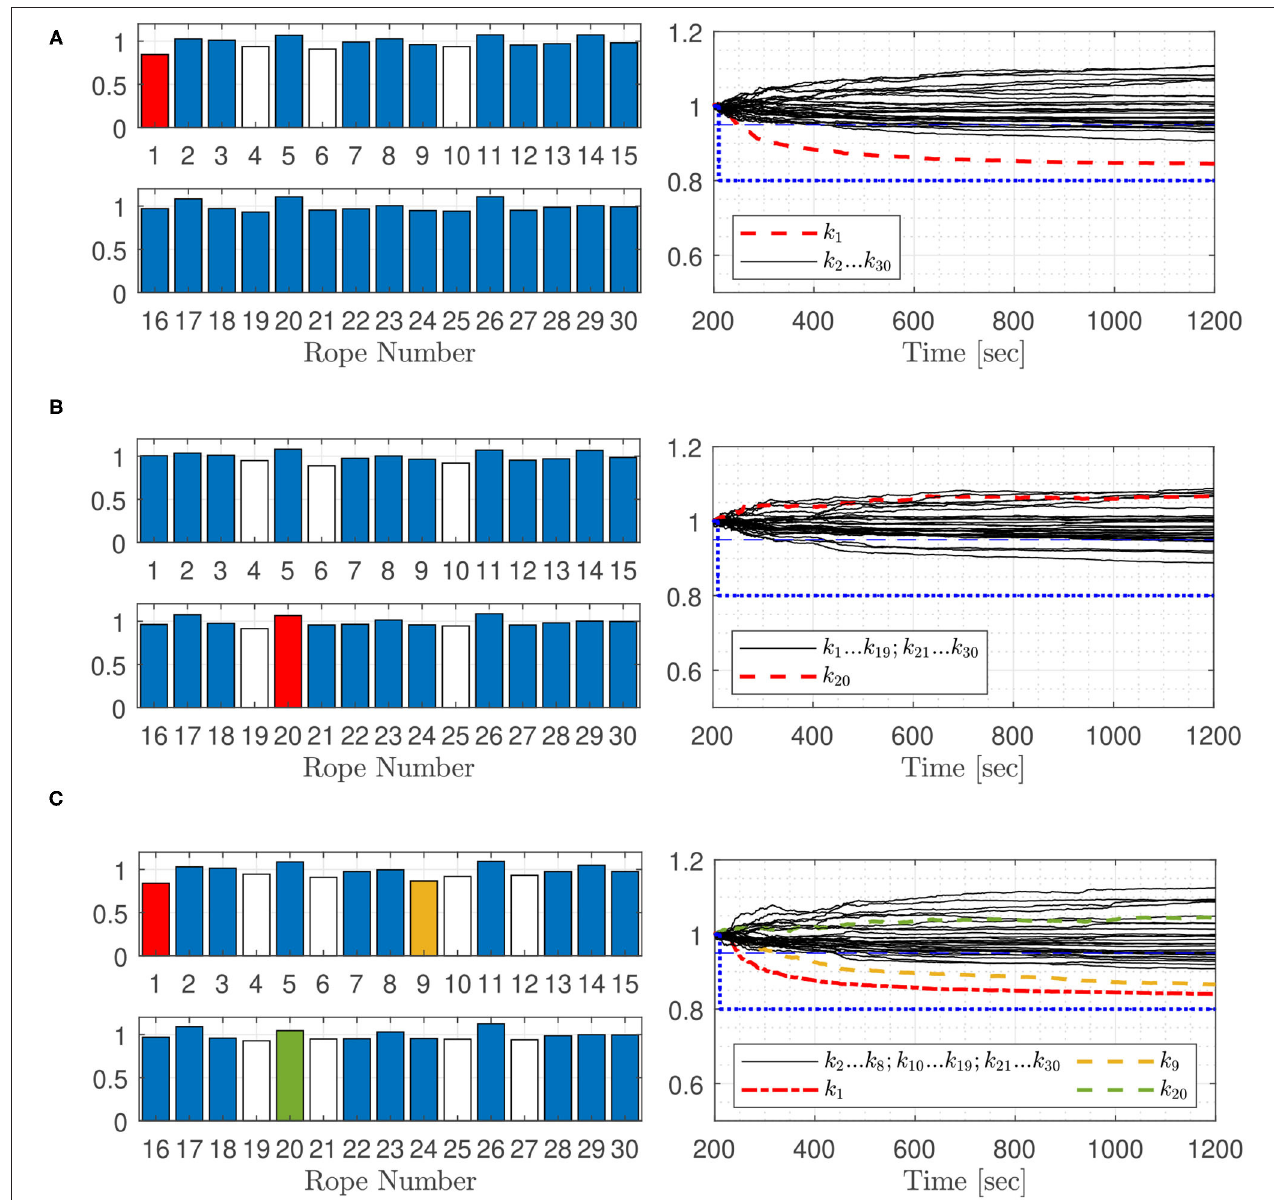
FIGURE 11 | Normalized estimated rope stiffness test cases 5A (A) , 5B (B) , and 5C (C) with acceleration sensor only placed on the edge- and corner